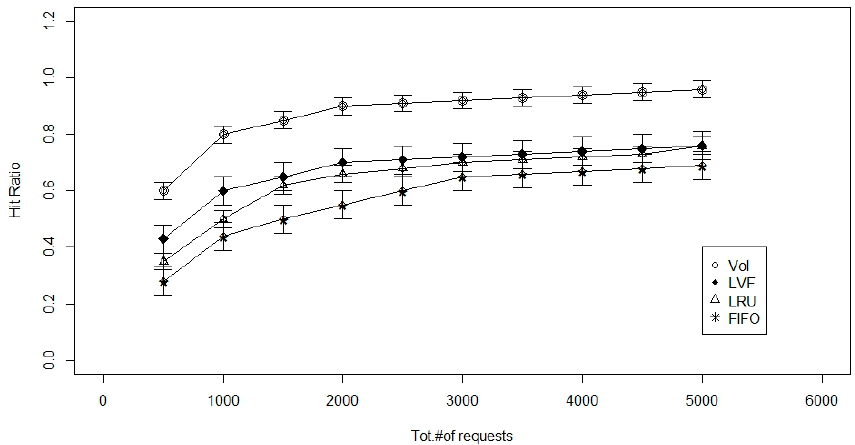
Figure 5. Total number of requests versus the hit ratio with 2-level caching.